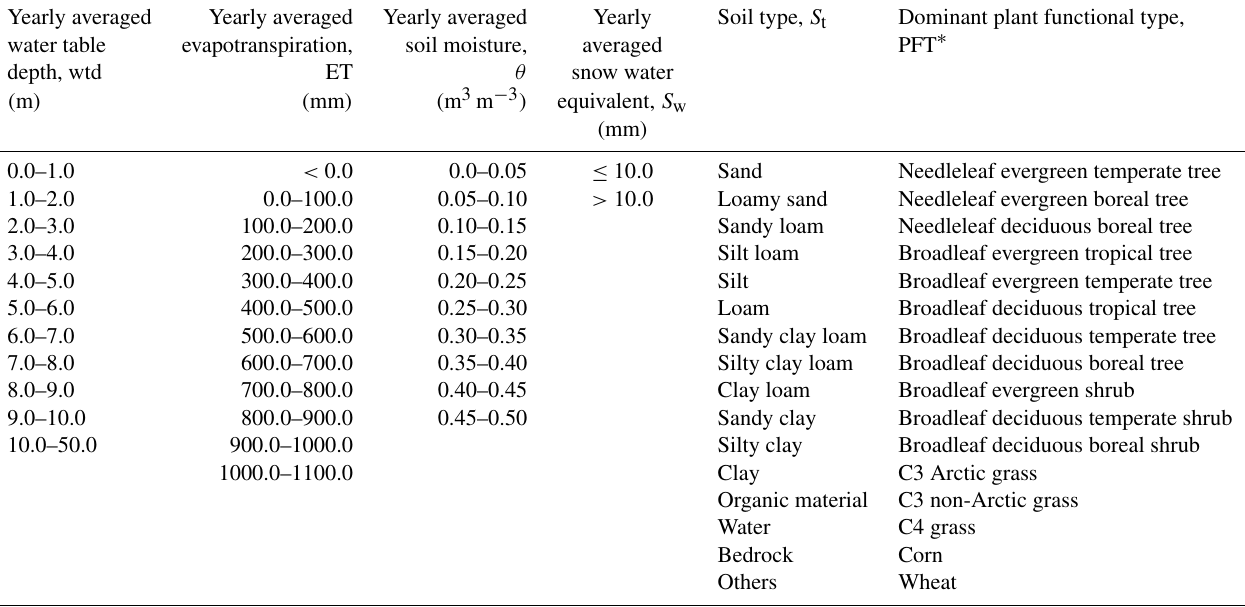
Figure 4. Workflow for LSTM network setup over the European CORDEX domain. The left section represents the overall processes of the network setup, whereas the right section shows how to apply LSTM networks at a selected pixel. The blue dashed lines with arrows indicate additional data transmission paths. Table 3. Intervals of yearly averaged wtd, ET, θ , S w , and S t and dominant PFT for categorization. Yearly averaged Yearly averaged Yearly averaged Yearly Soil type, S t Dominant plant functional